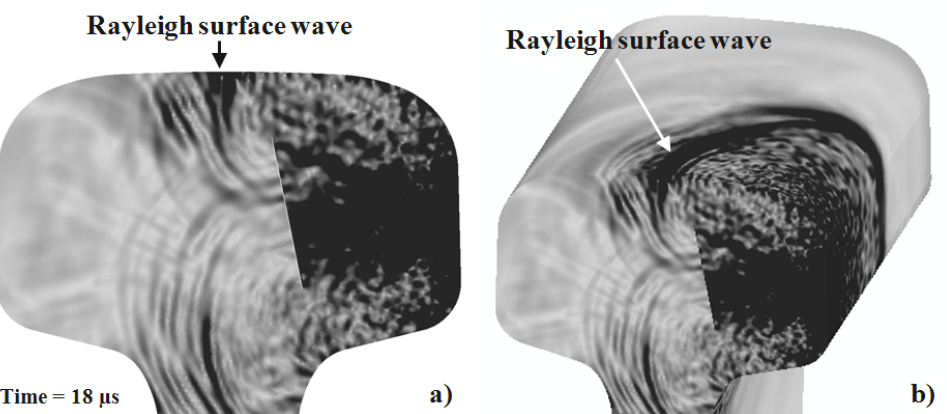
Figura 13: Mappa degli spostamenti al tempo 18µs dal modello agli elementi finiti per il fungo. Immagine 2D, a), e 3D, b), dove metà del modello è stato rimosso. Le regioni nere hanno spostamenti che eccedono il valore di 1  10 -5